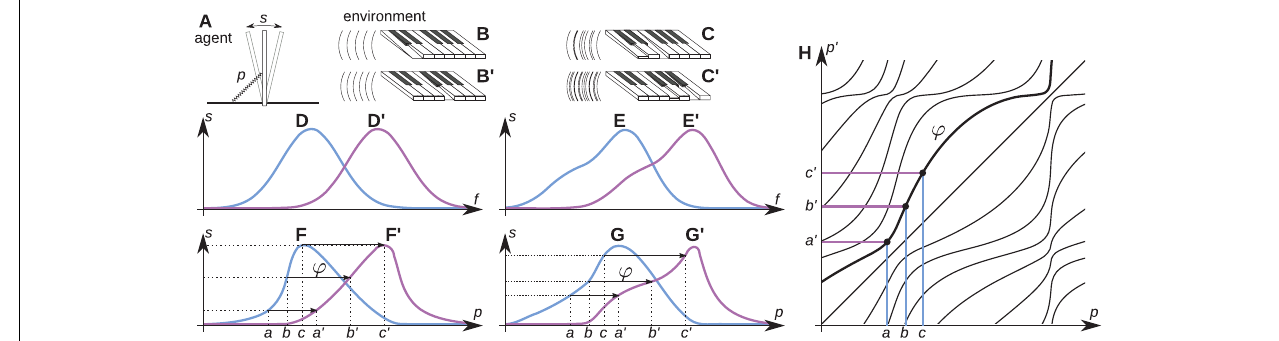
FIGURE 7 | A simple audio agent . The agent (A) consists of a rod attached to a support, oscillating in response to the acoustic waves (B) . The agent measures the intensity of this oscillation with an “exteroceptor” s . By exercising its muscle the agent can change the stiffness of the spring at the support and thus the eigenfrequency f of the rod, measured with the proprioceptor p . For an acoustic wave generated by a single note (A) the exteroceptor response s depends on the eigenfrequency f as shown in (D) . However, the agent measures the proprioceptive response p and not the eigenfrequency, and so only has access to the sensorimotor contingency (F) . The change of the note from (B) to (B ′ ) results in a shift in the characteristics (D) to (D ′ ) and in the establishment of a new sensorimotor contingency (F ′ ) . The agent can learn the functions φ (H) by taking note of the coincidences in the exteroceptor output s . If a pair of notes is played (C,C ′ ) with the dependencies (E,E ′ ) , new sensorimotor contingencies are obtained by the agent (G,G ′ ) , yet the same functions φ link them together. Reproduced with permission from Terekhov and O’Regan (2014) © 2016